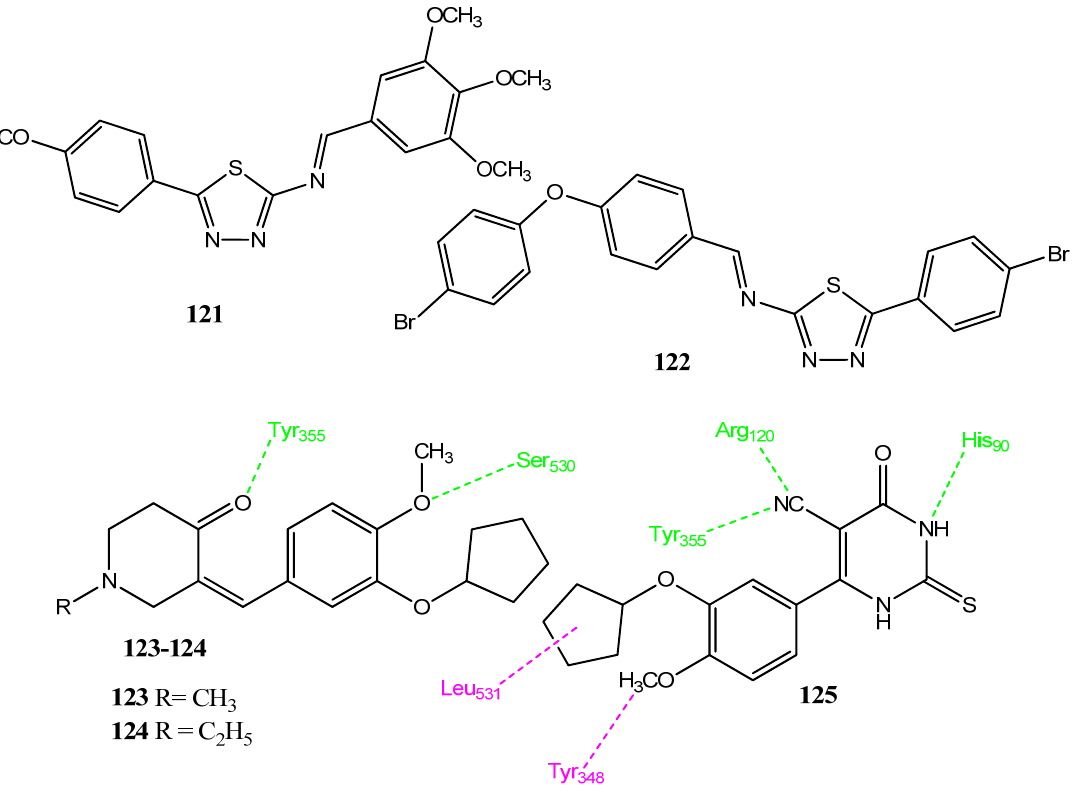
Figure 24. Thiadiazole and cyclopentolate